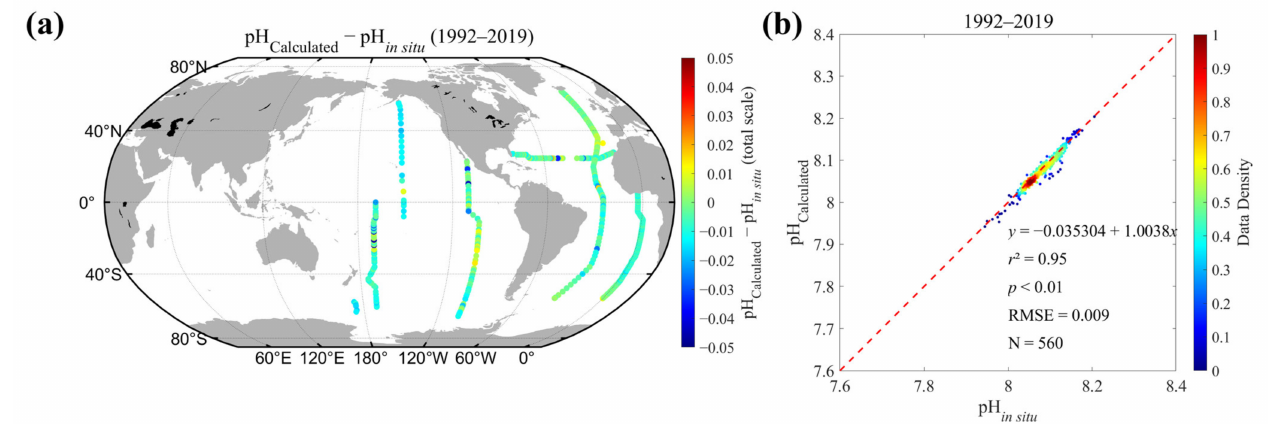
Figure 6. Validation of the calculated pH ( in situ *) based on the independent GLODAP dataset. ( a ) Comparison between pH ( in situ *) and the station sampling from GLODAP during the period 1992–2019 with data above 10 m water depth with a WOCE quality control flag of 2. ( b ) Scatter plot between the calculated pH and in situ pH in GLODAP along the 1:1 line with R 2 = 0.95, RMSE = 0.009, and n = 560.